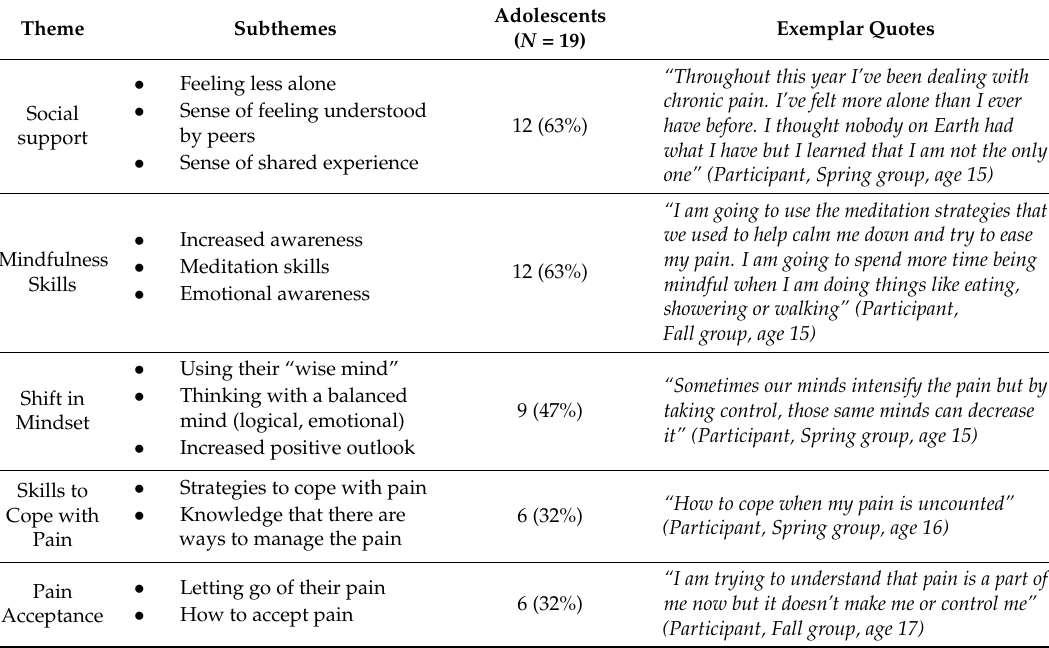
Table 2. Major themes from the satisfaction